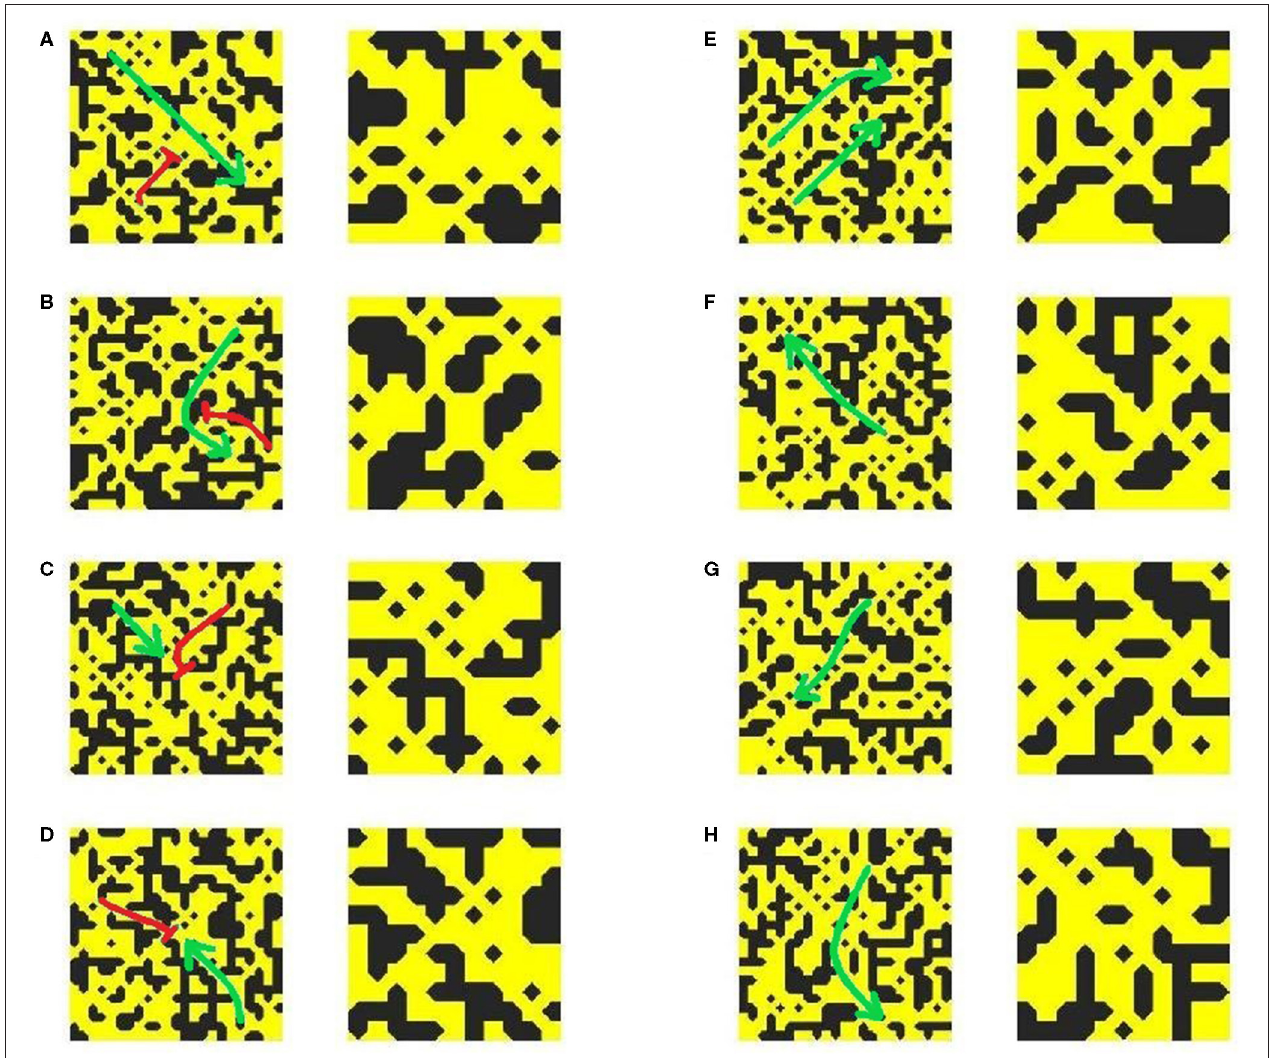
FIGURE 6 | Examples of pro-arrhythmic (A–D) and non-arrhythmogenic (E–H) micropatterns (23 × 23 elements), and a close-up view of the structure at their centre. Green arrows indicate the directions of AP propagation, with red flat arrowheads indicating conduction block.